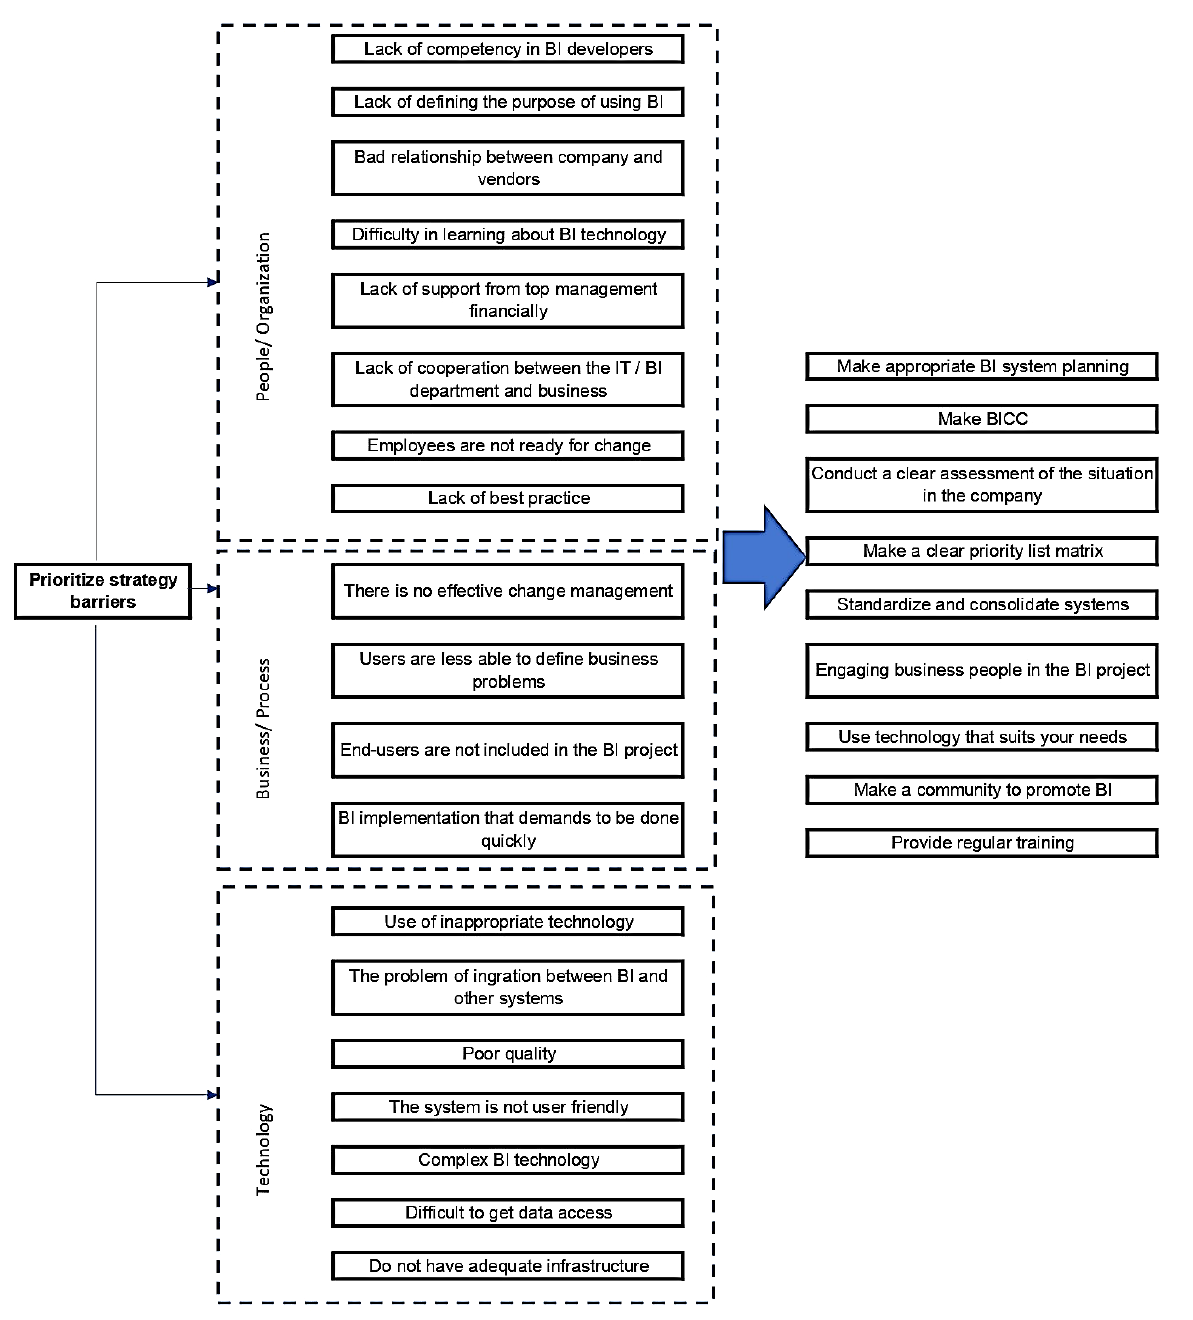
Figure 2. Fuzzy AHP-TOPSIS Framework for Developing Barriers to Priorities and BI Project Development